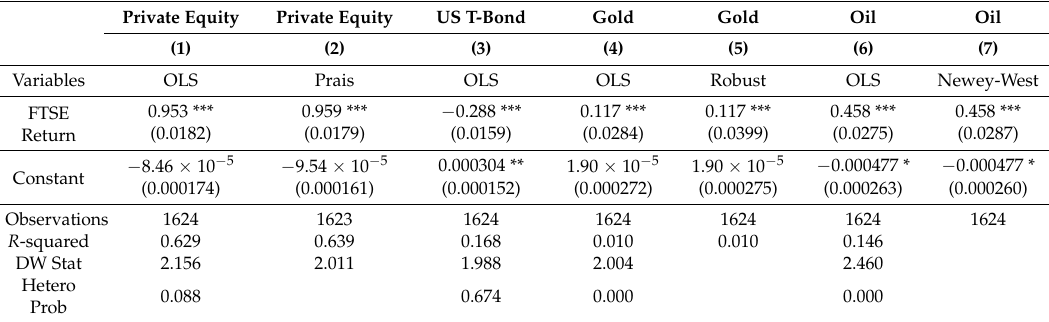
Table 5. Regression Models- Private Equity, US T-Bond, and Commodity Funds.